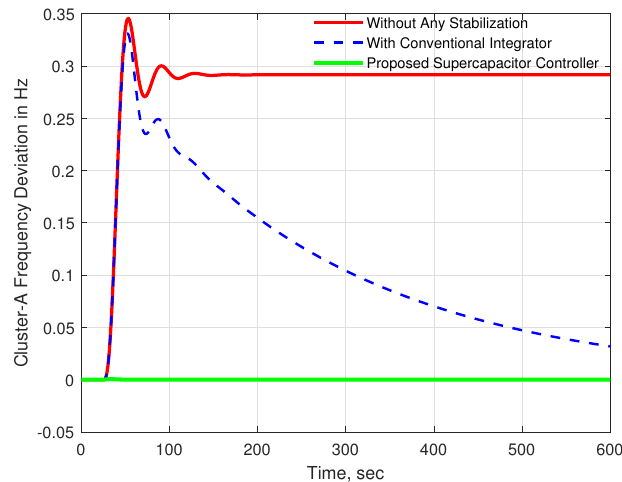
Figure 11. Frequency response for cluster A with 0.01 p.u. disturbance in cluster B.